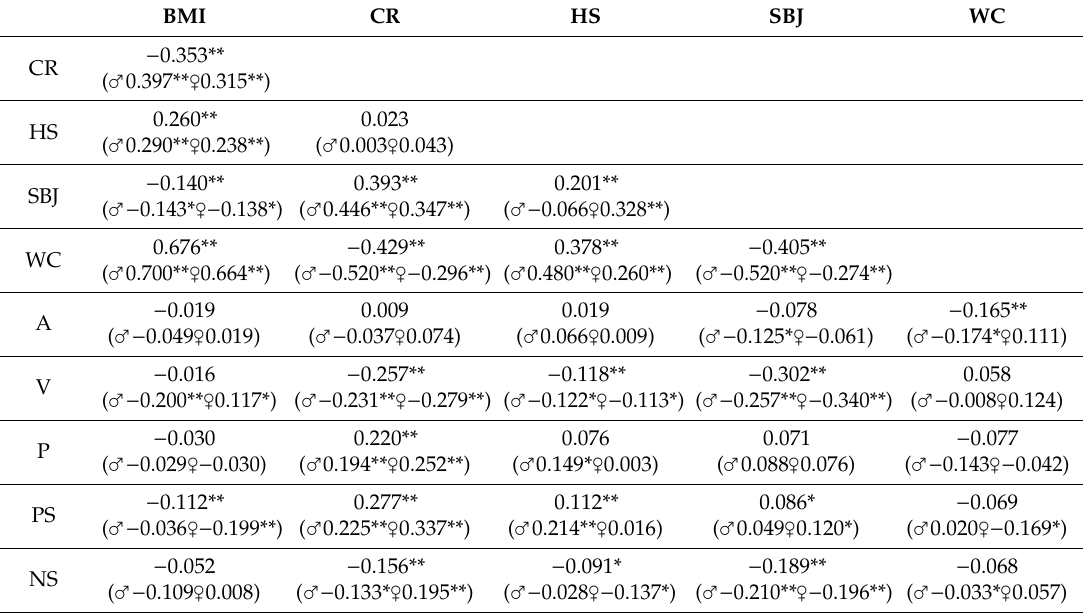
Table 2. Percentiles correlation between the PF levels and social